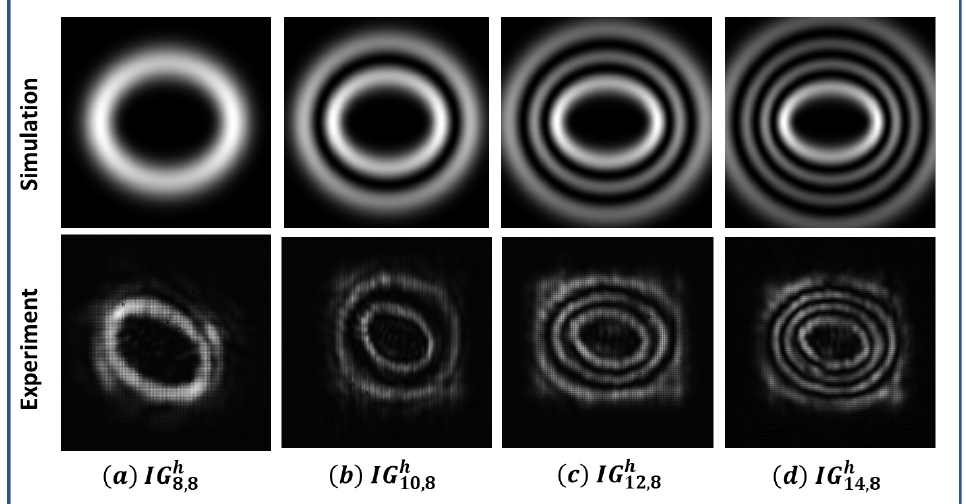
Figure 10. Intensity pattern of simulated and experimentally generated helical Ince–Gaussian